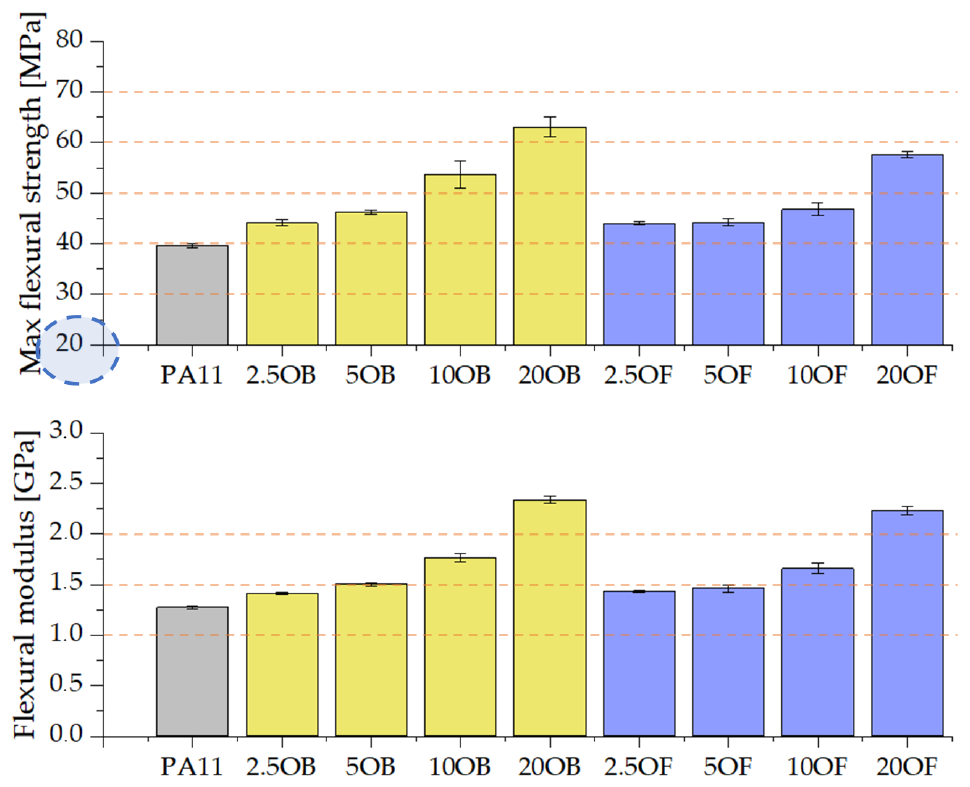
Figure 9. The results of the static tensile test are as follows: ( A ) the tensile strength and ( B ) the Young’s modulus of the biocomposites conditioned at room temperature (RT).